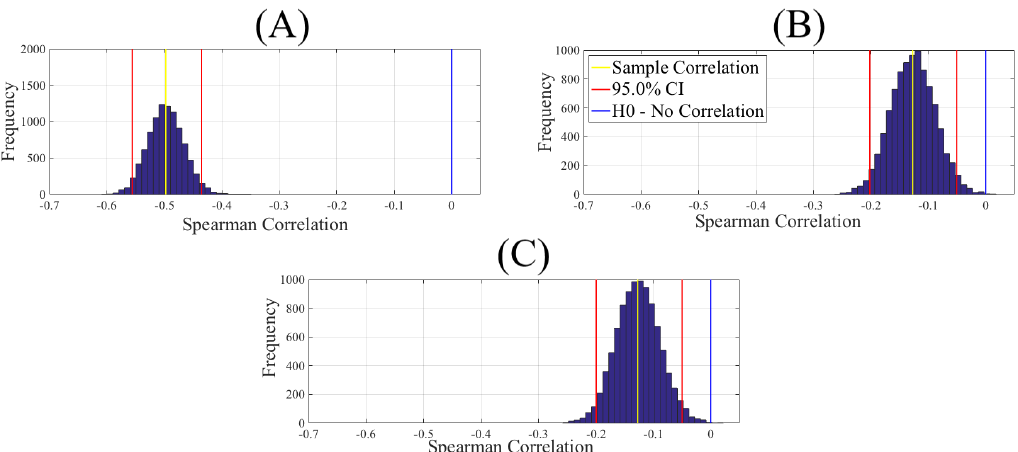
Figure A3. Spearman correlation between participants’ DEs (i.e., 62 DEs associated with 62 EEG channels of a participant, per affect) and their corresponding MSE1 values (i.e., 62 MSE1s associated with 62 EEG channels of a participant, per affect) in ( A ) negative, ( B ) neutral, and ( C ) Positive.